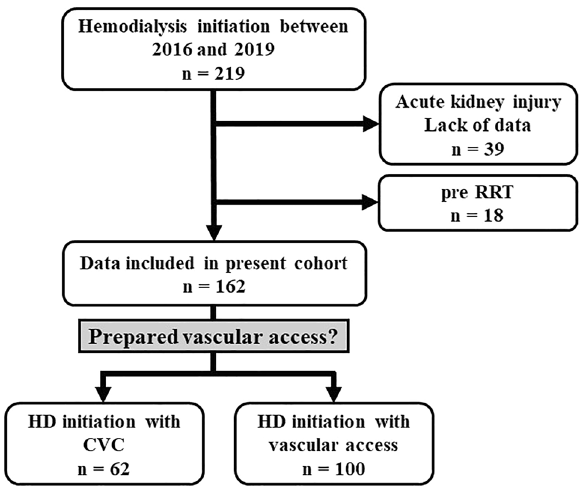
Figure 4. Flowchart of patient selection. Out of 219 patients screened between January 2016 and December 2019, we excluded 39 because of the presence of acute kidney injury and lack of data. Ordinarily, patients are referred to our department from other departments or clinics to prepare for vascular access and HD initiation. Of the 162 patients, the CVC and vascular access groups contained 62 and 100 patients, respectively. CVC, central venous catheter; HD,